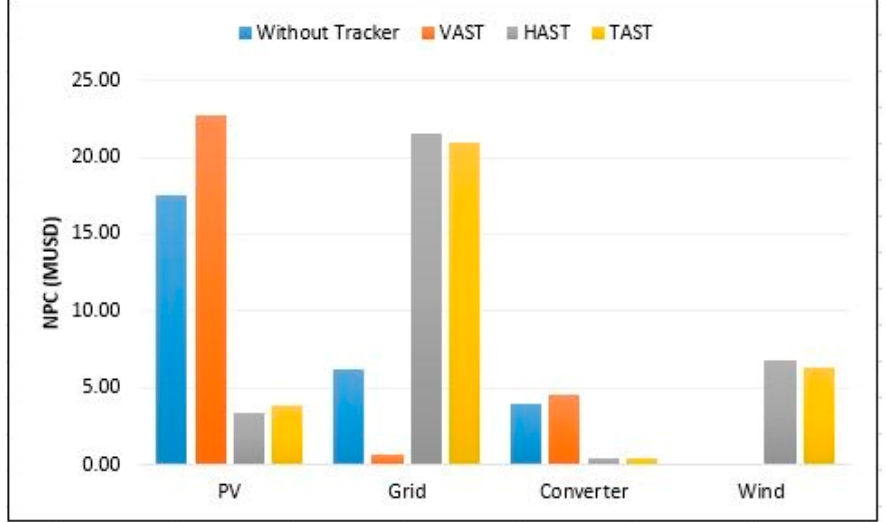
Figure 8. Comparing the net present cost of systems using different solar trackers and without solar tracker categorized by components .